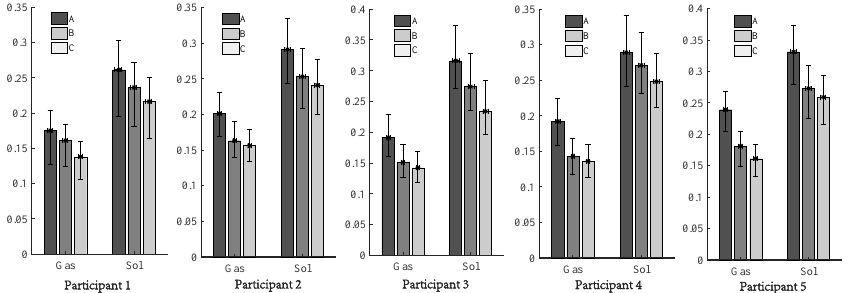
Figure 10. The muscle activation RMS value of participants under 0.8 m/s 2 vehicle acceleration.